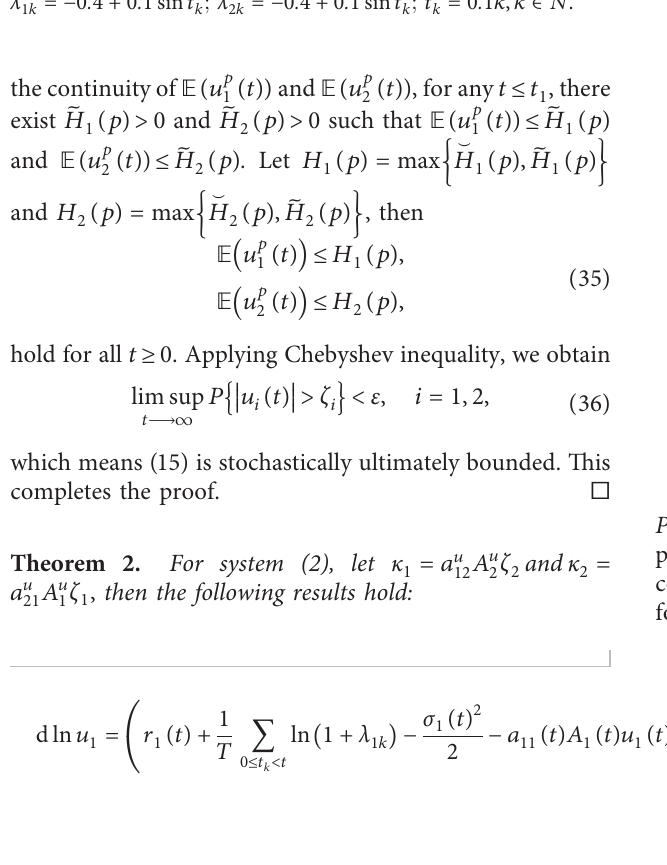
Figure 1: Periodic Markovian process for (2) with initial data x ( t ) , (c) the phase graph of deterministic system ( ξ of x 2